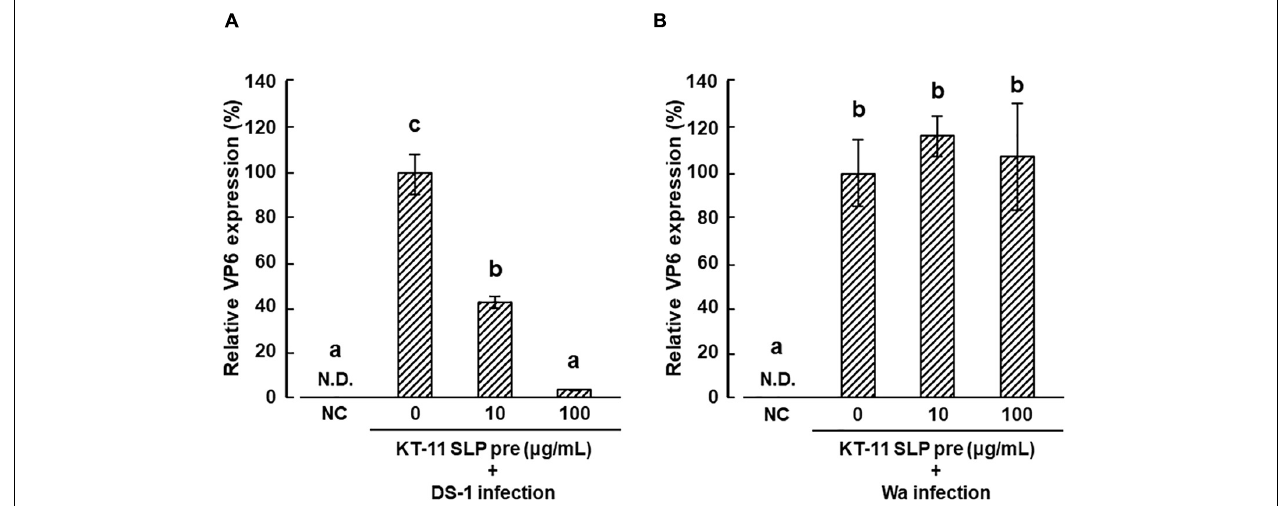
FIGURE 4 | Effect of KT-11 SLP against rotavirus infection in Caco-2 cells. Caco-2 cells were treated with KT-11 SLP at the indicated concentrations 1 h prior to DS-1 (A) or Wa (B) strain infection. The expression of VP6 in Caco-2 cells 24 h after infection was evaluated. The results are shown as means with standard deviations relative to KT-11 SLP-untreated and viral-infected control ( n = 3). NC represents the condition of viral-uninfected (and also KT-11 SLP-untreated) condition. N.D. denotes not detected. Different letters denote a significant difference at p < 0.05.